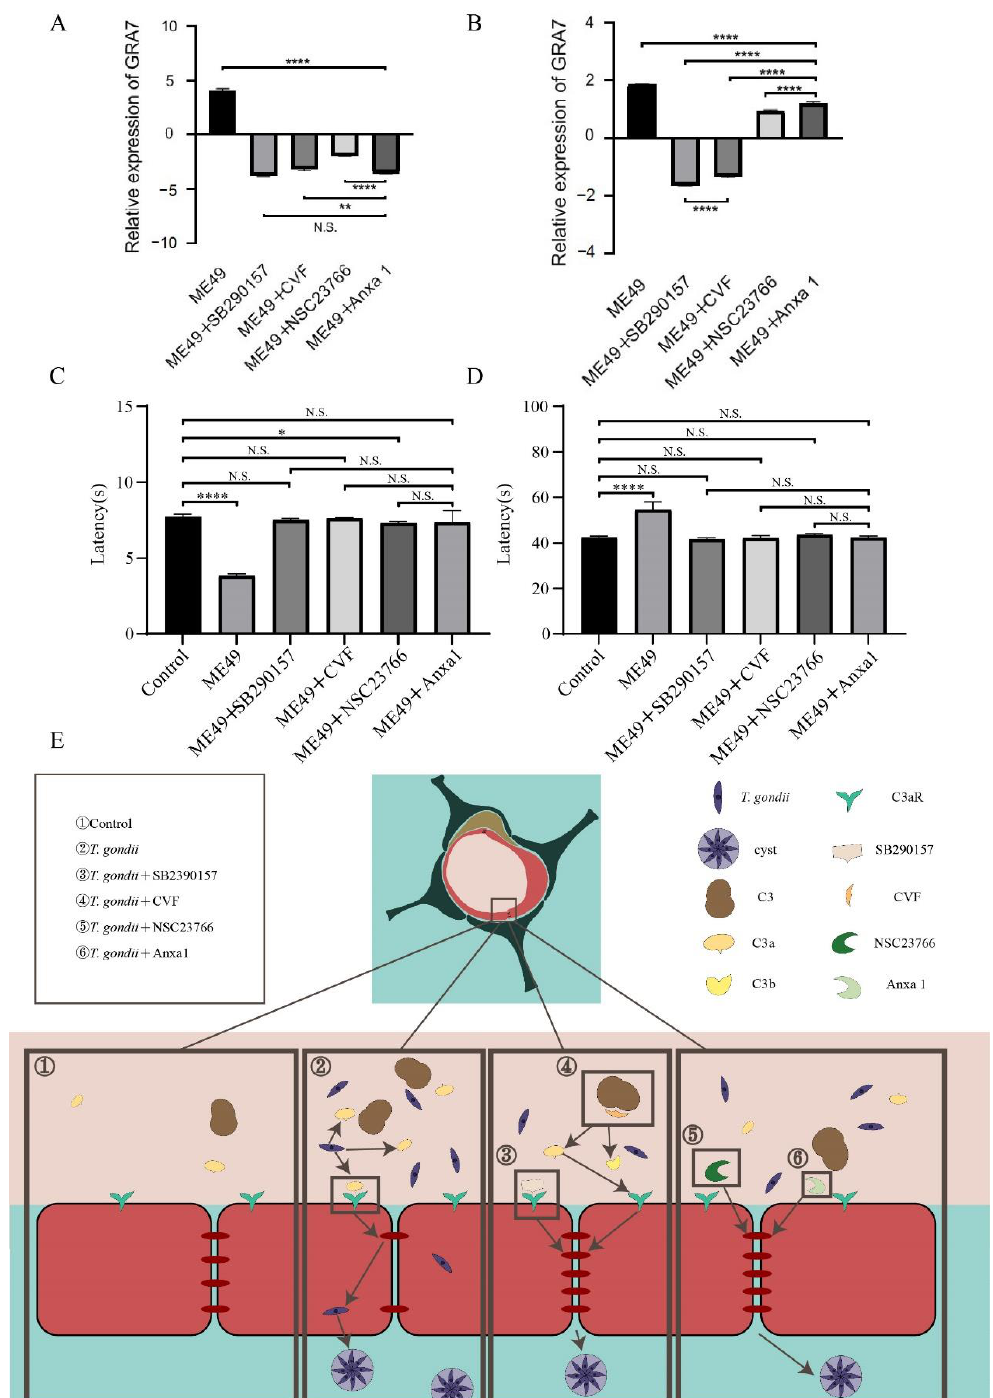
Figure 5. Four chemotherapeutic compounds inhibited T. gondii from entering the brains of mice and impairing their mental cognition. ( A , B ) The comparison of the expression of GRA7 in brain samples ( A ) and blood samples ( B ) of mice infected with ME49 and treated with four different chemotherapeutic compounds. The relative expression used β-actin to normalize. ( C , D ) The time comparisons obtained through rotating rod instrument experiment ( C ) and Morris Water Maze assay ( D ) by mice infected with ME49 and treated with different chemotherapeutic compounds. Statistical differences were analyzed by one-way ANOVA. N.S. p ≥ 0.05, * p < 0.05, ** p < 0.01, **** p < 0.0001. ( E ), Schematic model of four chemotherapeutic compounds inhibiting T. gondii from entering host brain tissue through the